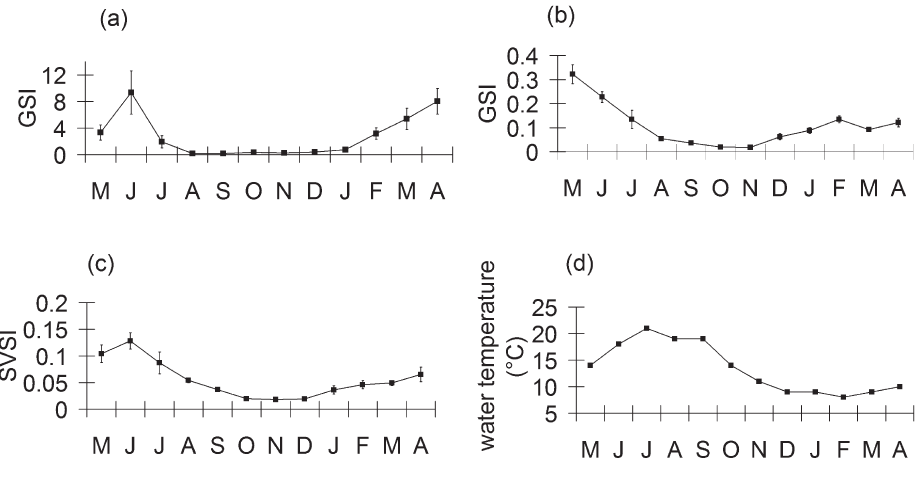
Fig. 2. – Mean (± standard error) monthly gonadosomatic index (GSI) of (a) female and (b) male and the seminal-vesicle-somatic index (SVSI) (c) of Buenia affinis from the Kvarner area. Mean monthly sea temperature at the collecting depth is also given